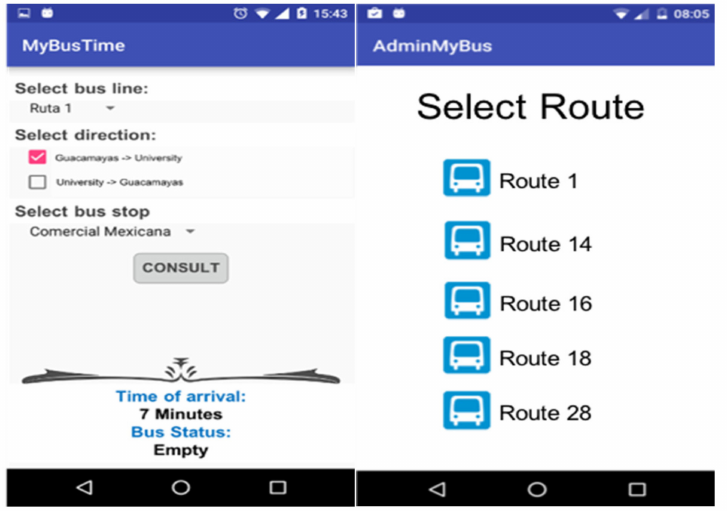
Figure 17. Some views of the interface of the Passenger Transport App.